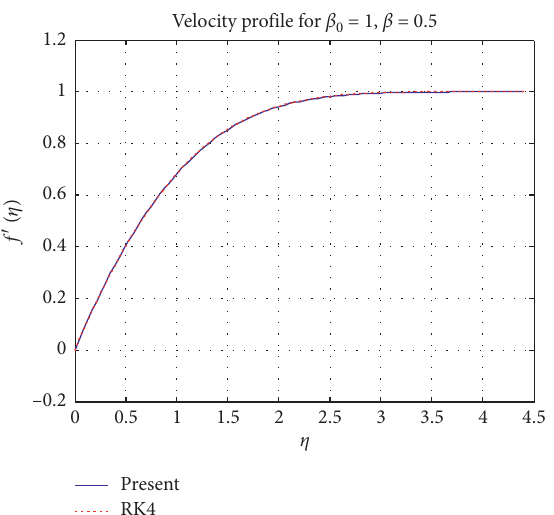
Figure 4: Velocity profile of the Hiemenz flow ( β f ″ ( 0 )� 1.232588438646 for L �